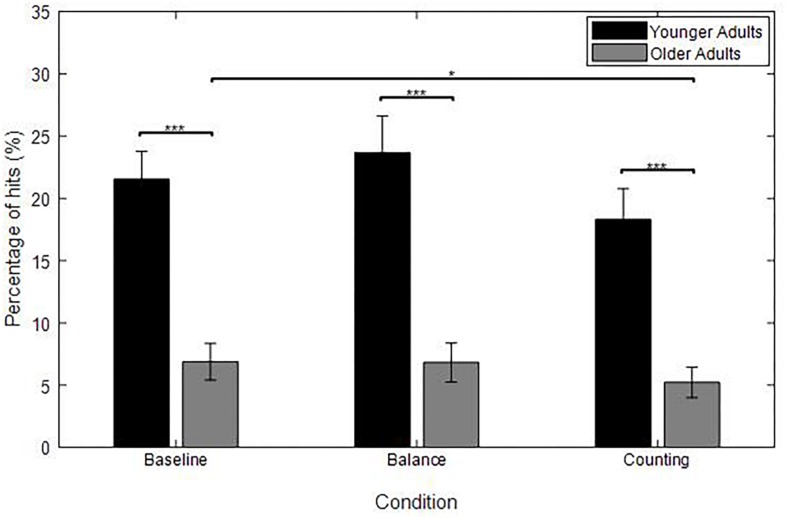
Average percentage of hits for each group [YA (n = 19), OA (baseline: n = 22, balance: n = 19, counting: n = 16)] and for each experimental condition (baseline, balance, and counting); averaged over the target’s motion direction (horizontal velocities: −7.2, 0, and 7.2 cm/s). Error bars represent the standard error of the mean between subjects. Significant differences are represented with asterisks in the figures; *p < 0.05; ∗∗∗p < 0.001.